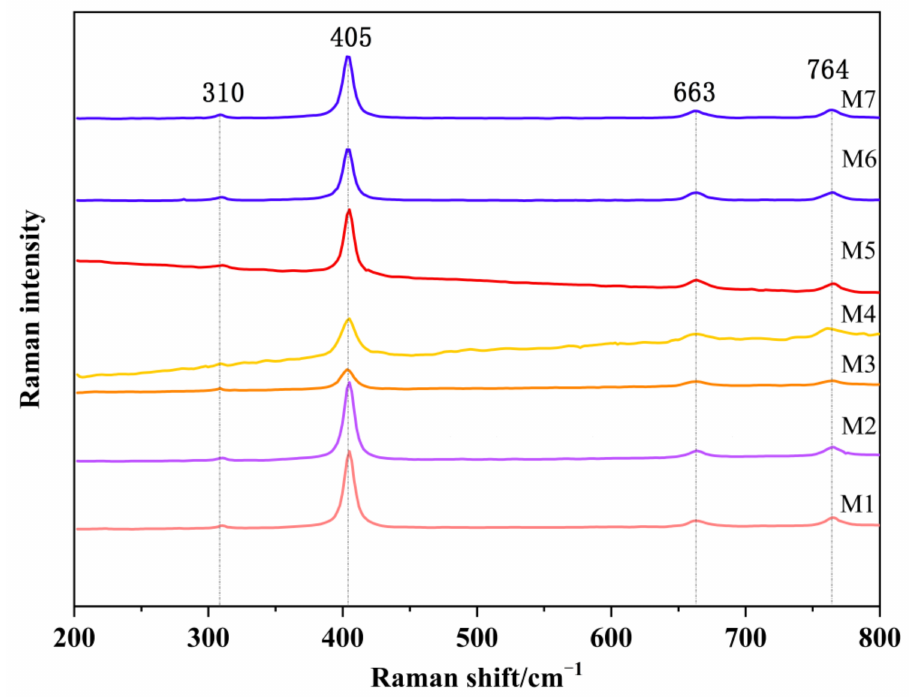
Figure 5. Raman spectra of different colored spinels from Myanmar.